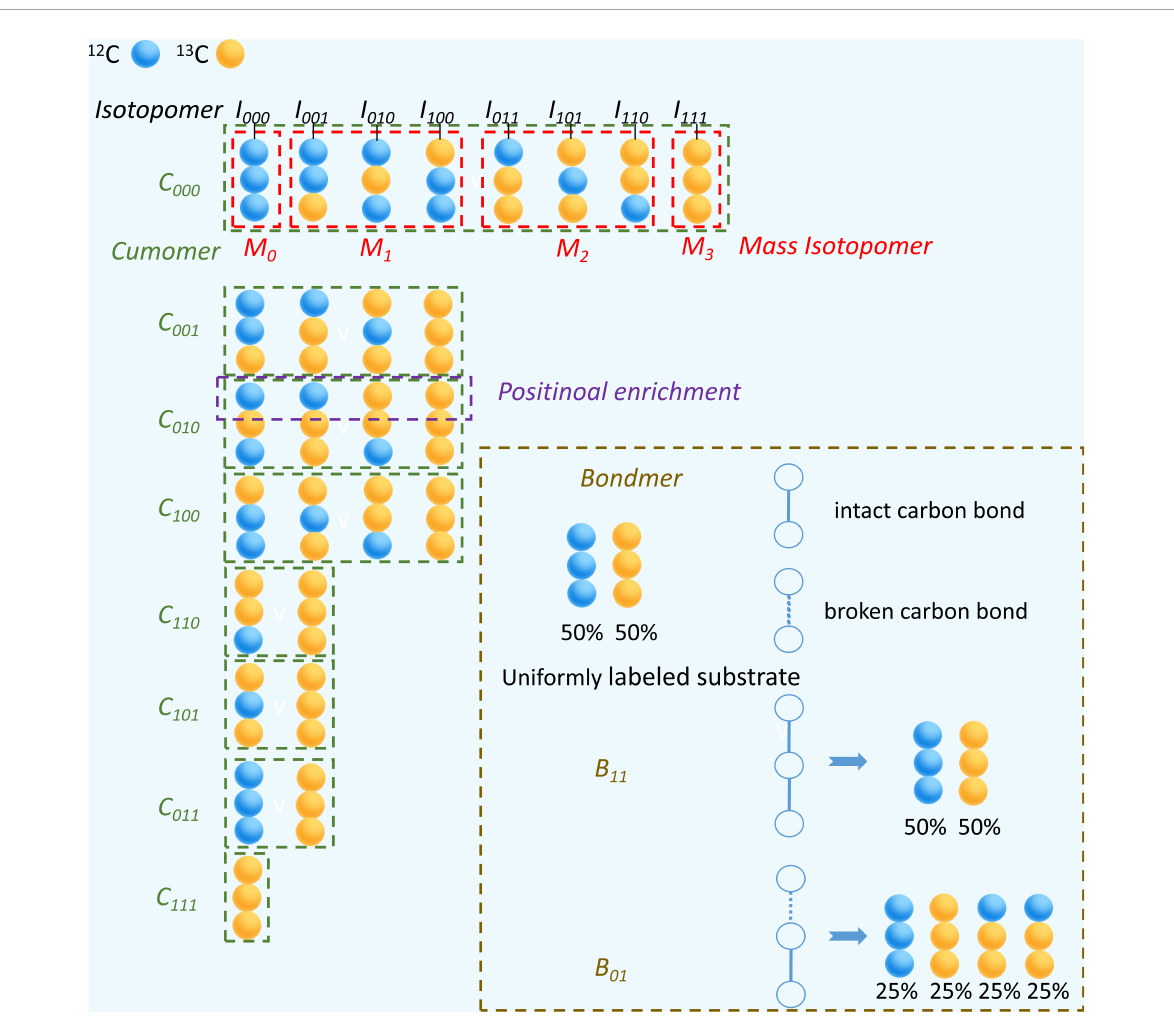
FIGURE4 Characterization of different 13 C isotope labeling model with a 3 carbon atoms metabolite. Blue ball represents 12 C and yellow ball represents 13 C. The isotope molecule associated with black line segment is specific type of isotopomer, such as I 100 . The isotope molecules in red dashed box belong to the same group of mass isotopomer, such as M 1 . The isotope molecules in green dashed box belong to the same group of cumomer, such as C 100 . In brown dashed box, white open circle represents a carbon position, blue represents a carbon-carbon bond that has never been broken by any reaction and blue dashed line represents a carbon-carbon bond that has been broken by a reaction and rejoined by another reaction. The percentage below a isotopic molecule is its abundance